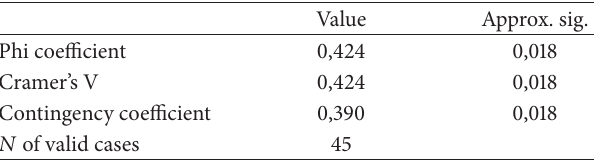
Table 3: Symmetric